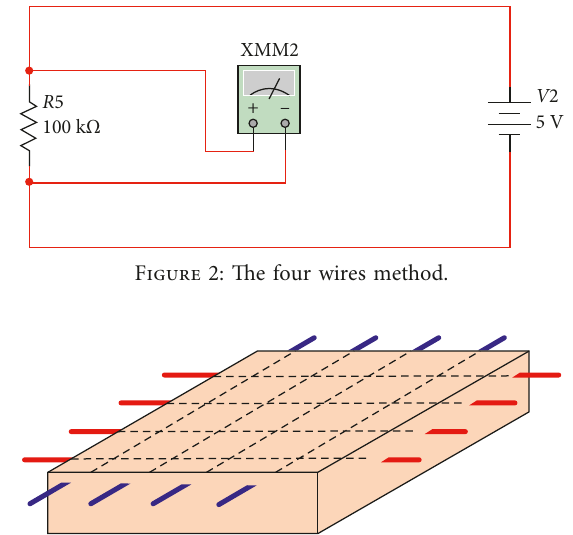
Figure 3: Flat mesh macrostructure of the carbon nanotube line.